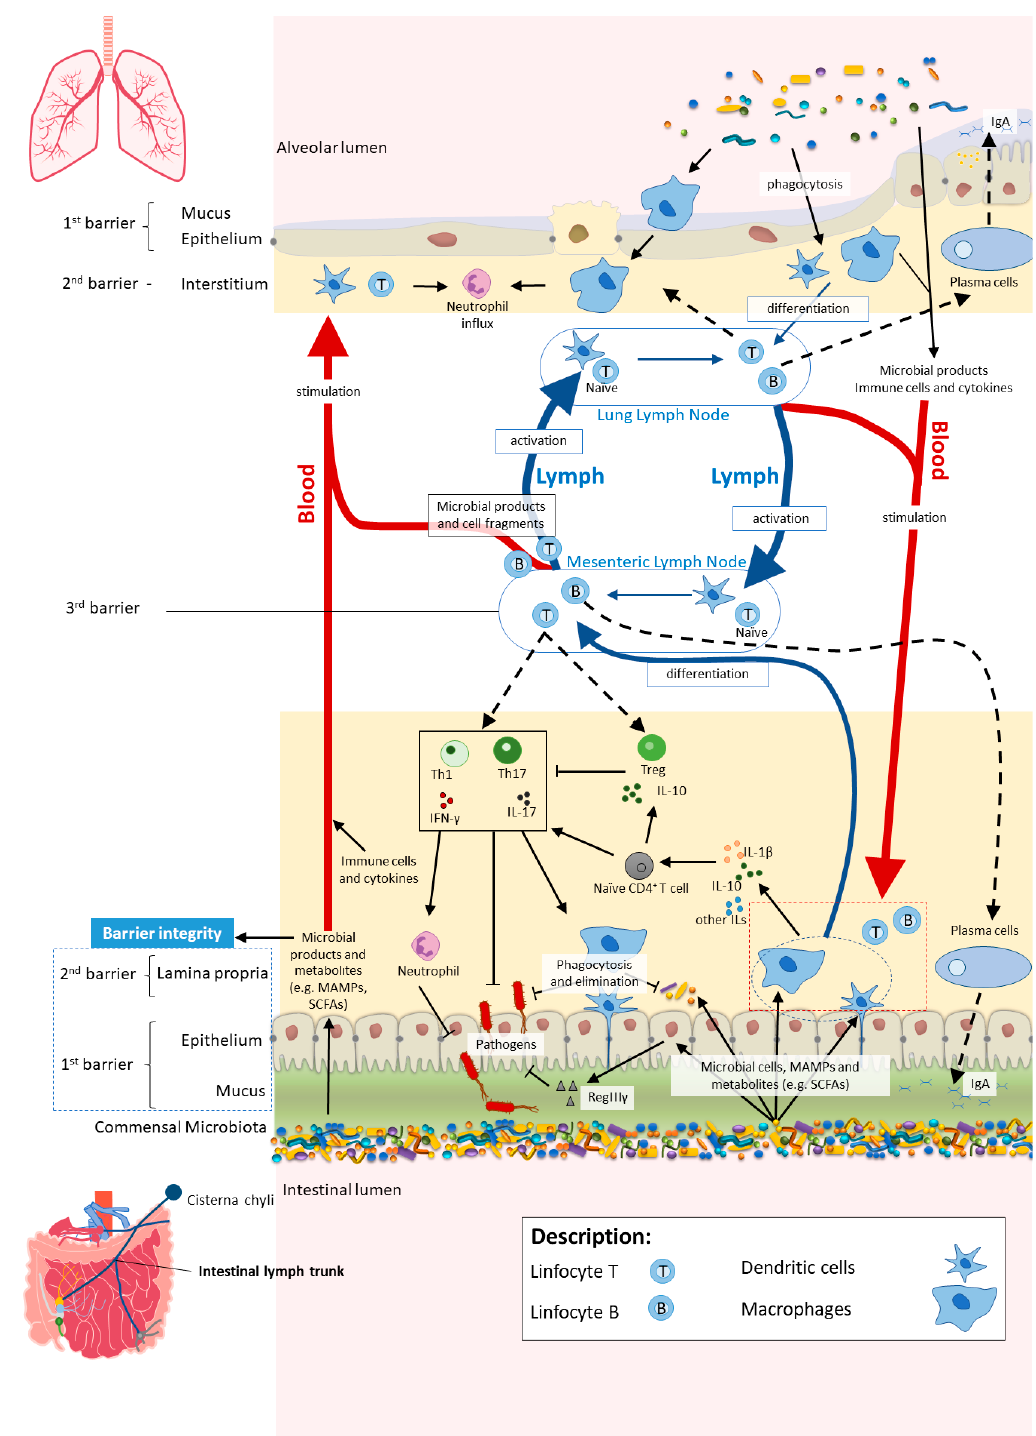
Figure 2. In homeostasis, microbe-associated molecular patterns (MAMPs) from the gut microbiota are recognised by pattern recognition receptors (e.g., Toll-like receptors (TLRs)) and induce antigen presenting cells (APCs), such as macrophages and dendritic cells (DC), to produce interleukins (e.g., IL- 1 β and IL-10) to regulate immune responses by different subsets of T cells, neutrophils and macrophages, among others. Activated APCs induce differentiation of naïve CD4 + T cells into CD4 + regulatory T cells (Treg) (which are crucial for both maintaining tolerance to commensal microbiota and regulating other immune cells), and other effector T cells such as Th1 or Th17 (expressing cytokines, e.g., IL-17 and interferon gamma (IFN γ )) with a central role in host defence against invading pathogens, while controlling the expansion of commensals. Microbial cells or their products in the lamina propria are either phagocytosed and eliminated or transferred to mesenteric lymph nodes (MLN) by APCs, where they induce differentiation of the T and B cells. Activated B and T cells move back (black dashed arrows) to the intestinal mucosa to directly act on their target or to continue to trigger other